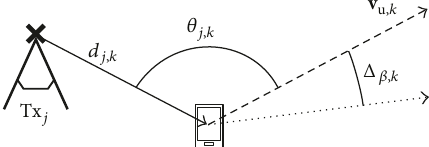
Figure 3: The user moves in the direction k at time instant 𝑘 . u ,𝑘 The heading change rate from the IMU is Δ 𝛽,𝑘 . The ToA and AoA measurements for the signal from the 𝑗 th transmitter are 𝑑 𝑗,𝑘 and 𝜃 𝜃 𝑗,𝑘 , respectively, where 𝑗,𝑘 describes the angle between the heading direction k of the user and the arriving u ,𝑘